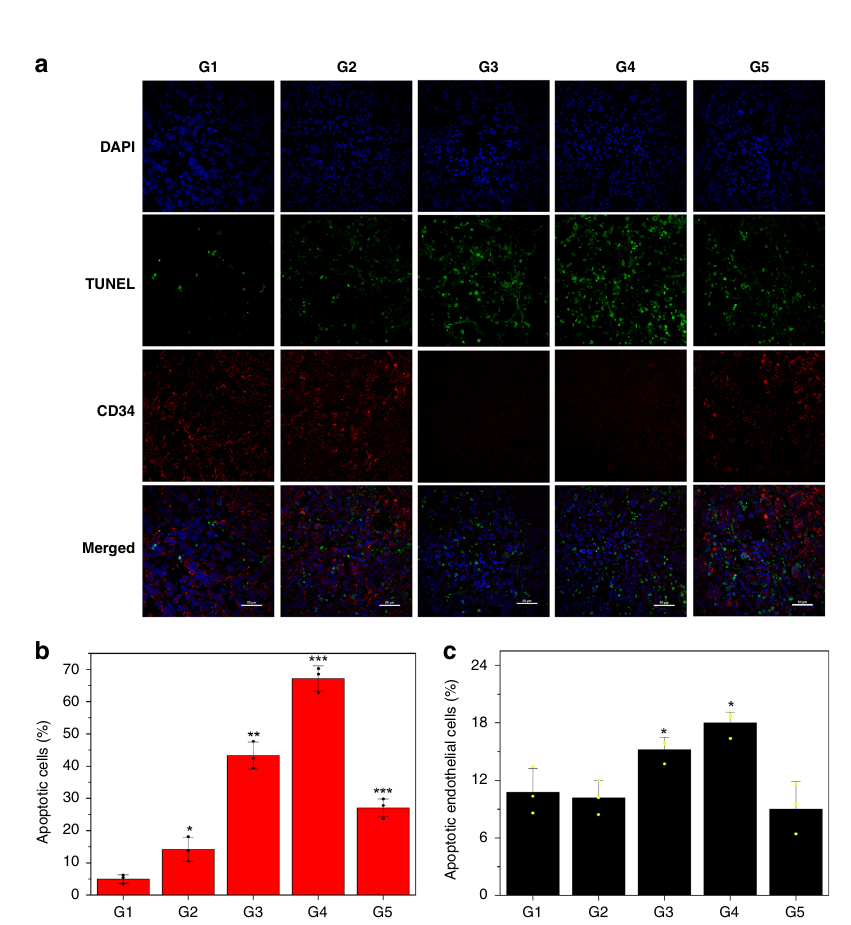
Fig. 6 In vivo principle exploration of anti-tumor using this special treatment method. a LCSM images of PANC-1 tumor slices co-stained by TUNEL immuno fl uorescence & CD34 immuno fl uorescence that were harvested after sacri fi cing of PANC-1-bearing nude mice treated with aforementioned different treatments (G1-G5) on the 10th day post-treatment, scale bar: 50 μ m, and TUNEL & CD34 immuno fl uorescence co-staining was employed to determine cell apoptosis and vascular density, respectively, wherein FITC (green) and TRITC (red) were used to label TUNEL and CD34, respectively, and nuclei (blue) was stained by DAPI. b , c Semi-quantitative data of apoptotic cells ( b ) and apoptotic endothelial cells in all apoptotic cells ( c ) after different treatments with G1 – G5 via calculating the ratios of green-labeled cells in whole blue-labeled cells and red and green co-labeled cells in all green-labeled cells according to the TUNEL immuno fl uorescence staining, respectively. Data are expressed as mean ± SD ( n = 3). * P < 0.05, ** P < 0.01 and *** P < 0.001, and the statistical signi fi cances were obtained using student's t test in comparison to G1. Note: G1-G5 represent control, Laser + GNR, Laser + hydrogel – GNR (1), Laser + hydrogel-GNR (2) and pNIPAAm, result is completely consistent with previous report focusing on intravascular aggregate-mediated blood & nutrition occlusion for starvation therapy 10 . Noticeably, no expression variation of Bcl-2 pro-apoptotic protein indicates HIF 1 α elevation can trigger apoptosis through the pathway, i.e., the stabilization of P53 47,48 . Intriguingly, the largest down-regulations of CD34 and CD31